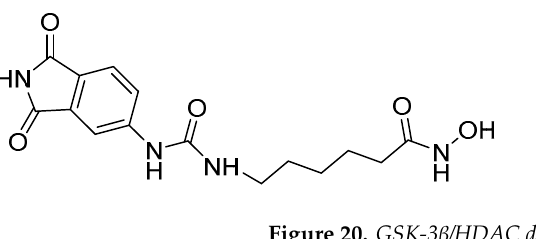
Figure 20. GSK-3 β /HDAC dual inhibitor [184] .